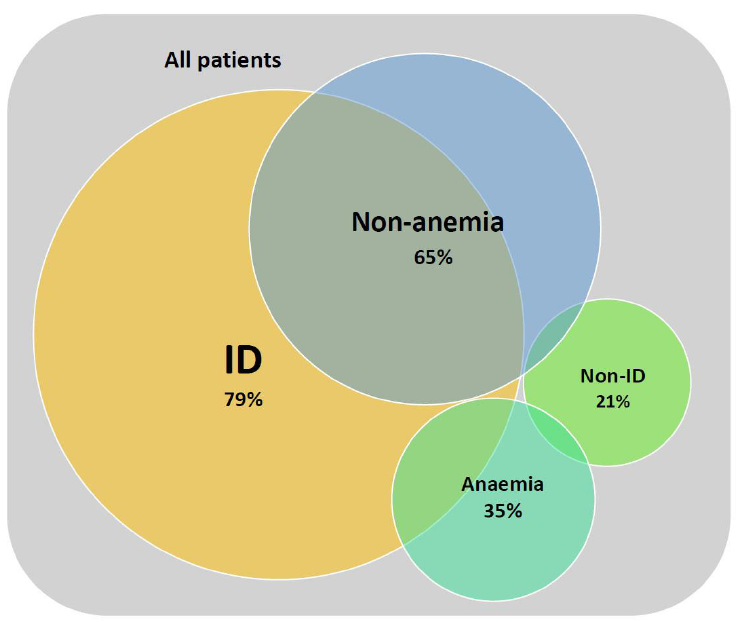
Figure 1. Prevalence of ID and anaemia in whole study group. The baseline characteristics of study groups are shown in Table 1.